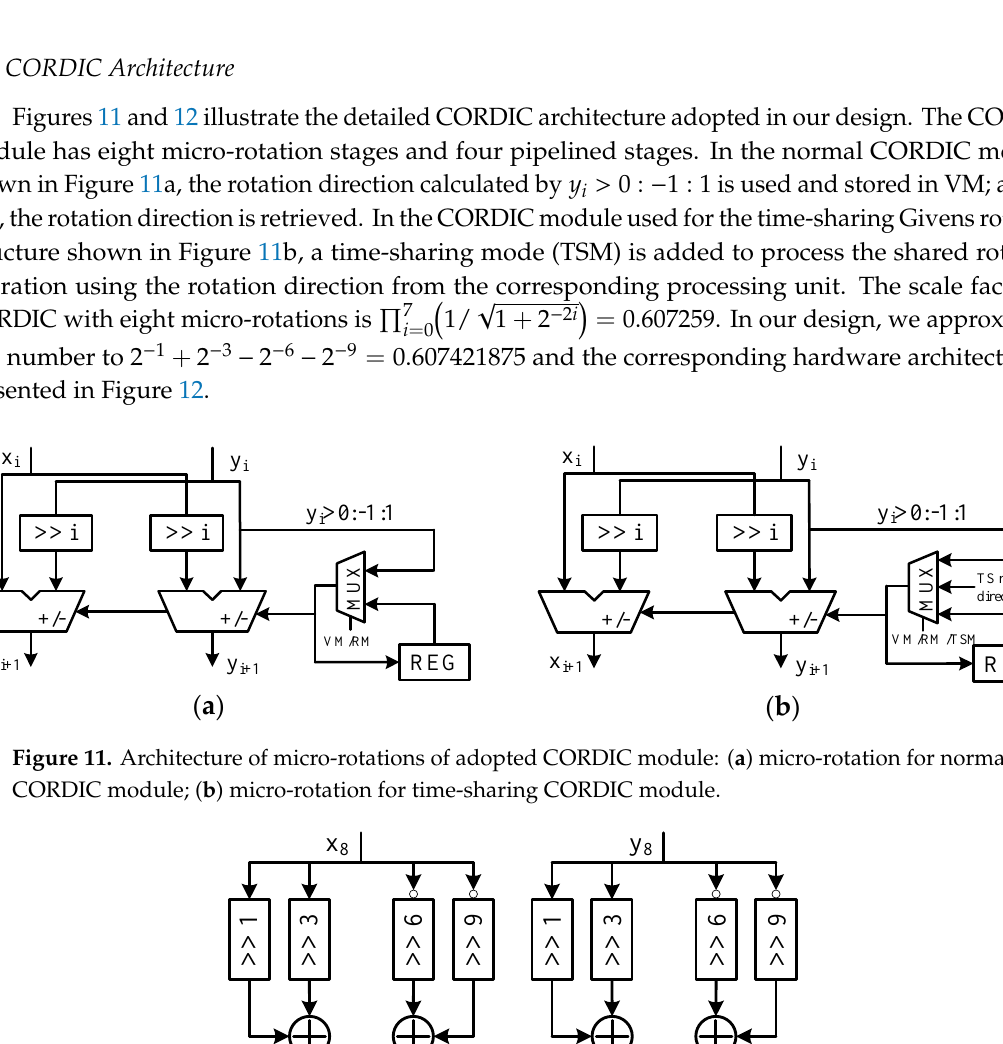
Figure 10. Processing flow of time-sharing Givens rotation structure.